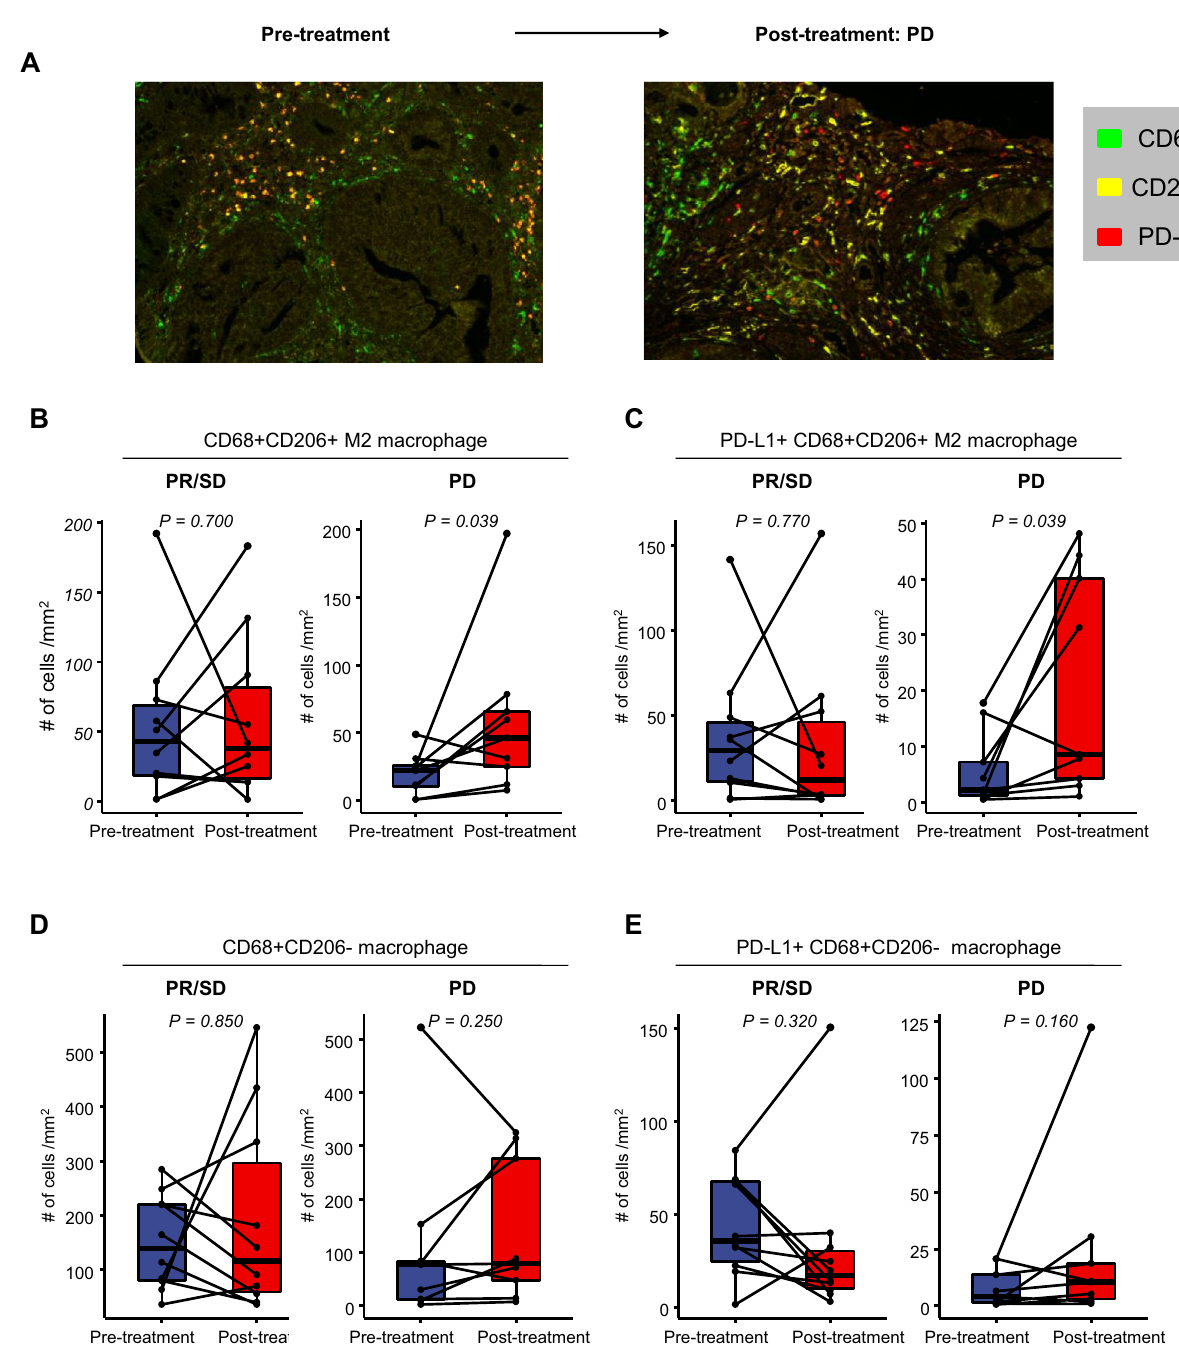
Figure 4. Dynamic changes of the density of the M2 macrophages according to different clinical settings. ( A ) Representative scans of multiplexed immunohistochemistry showing dynamic changes of CD68, CD206 and PD-L1 between pre-treatment tumor and post-treatment tumor with progressive disease. ( B – E ) Dynamic changes in the density in the following immune subsets according to the clinical response: ( B ) CD68 + CD206 + M2 macrophages; ( C ) PD-L1 + CD68 + CD206 + M2 macrophages; ( D ) CD68 + CD206 − macrophages; and ( E ) PD-L1 + CD68 + CD206 −